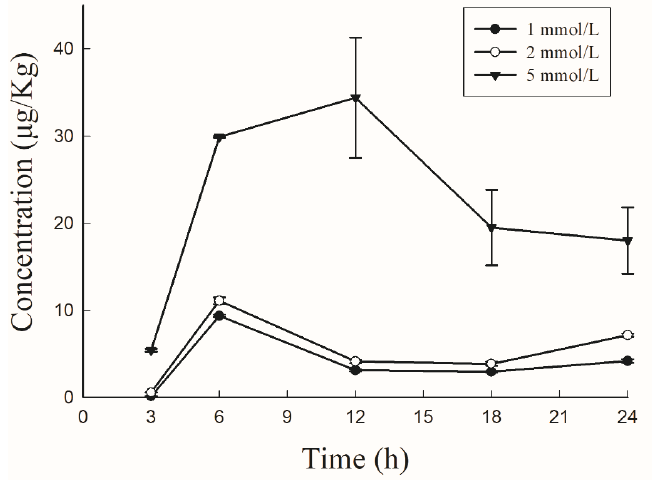
Figure 7. Concentration of tested compounds in castor roots was collected at 1 h intervals for 24 h. Each point was the mean of three sets of 12 plants ± SE.